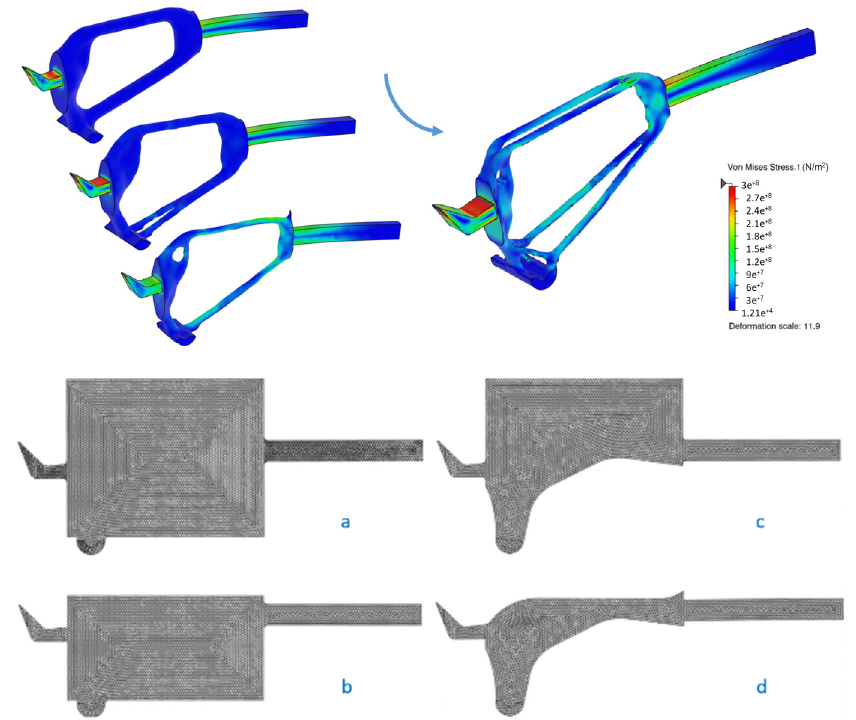
Figure 7. (Top): Topology optimisation refinement of the concept ( a ) and (bottom): a comparison of the enlarged ( a ), the top-limited ( b ), the bottom-limited ( c ) and the fully limited ( d ) design spaces.